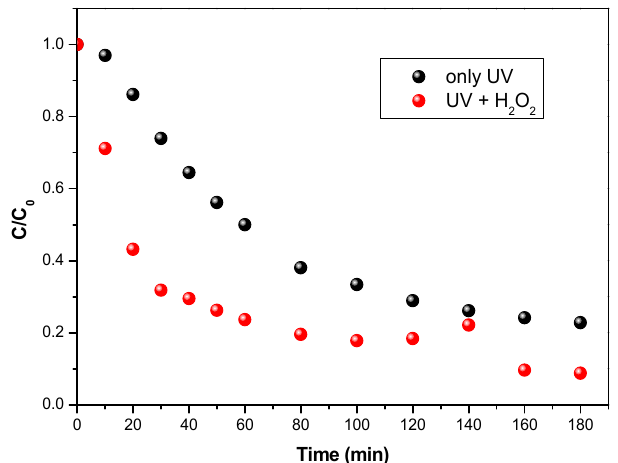
Figure 9. Evolution of the concentration of flumequine: comparison between UV alone and coupling UV + H 2 O 2 . C 0 flumequine = 5 mgl/L and a flow of 29 L/h. n 0 H 2 O 2 = 1 µ